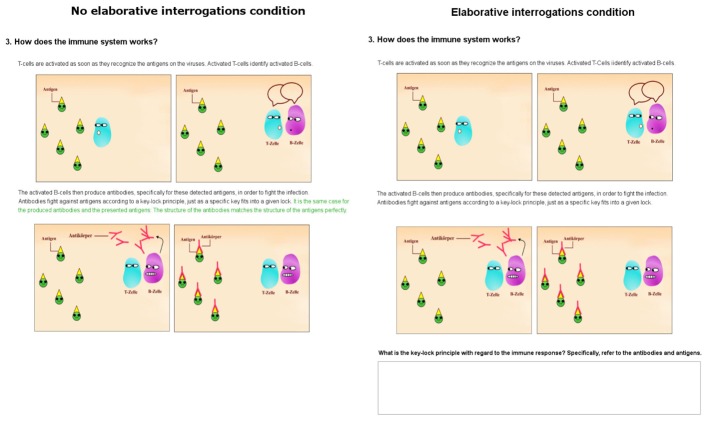
Examples of an instructional material page in the intended-positive emotional design for both SGL activity conditions. (Left) No elaborative interrogations condition (letters highlighted in green are for illustrational purposes only). (Right) Elaborative interrogations condition. The condition titles are also for illustration purposes only, but were not presented in the instructional material. The original instructional material was in German.